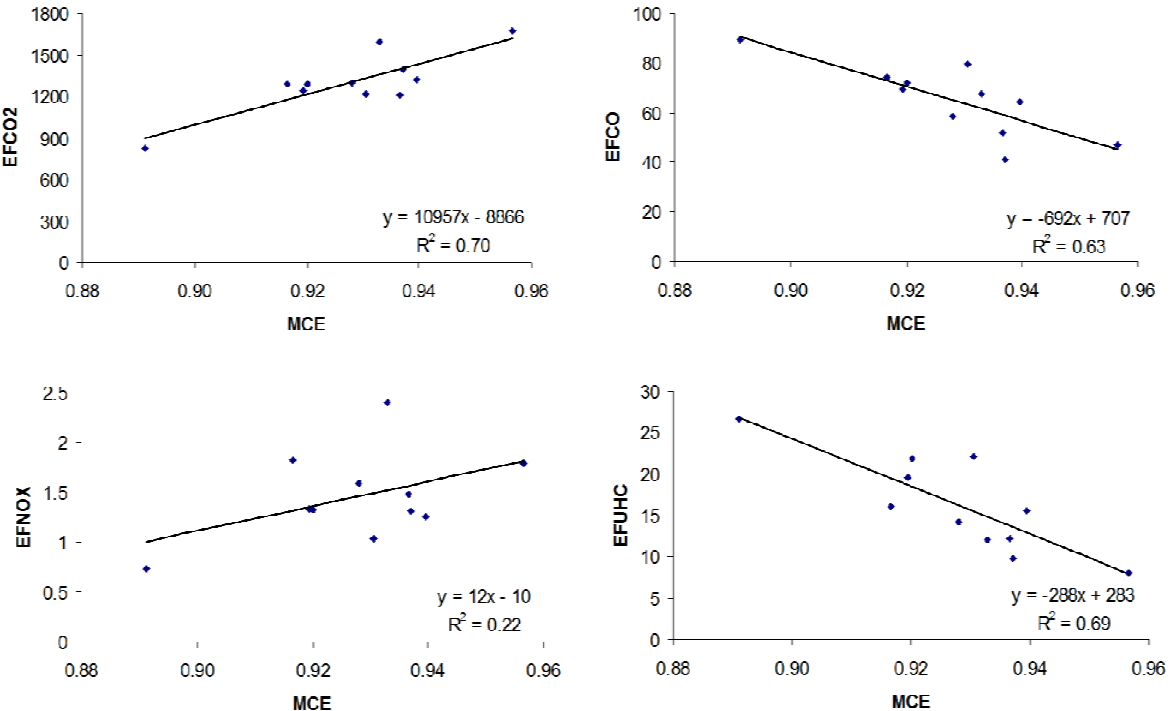
Figure 4. Graphical representation of the emission factors (EF) for CO UHC versus the modified combustion efficiency